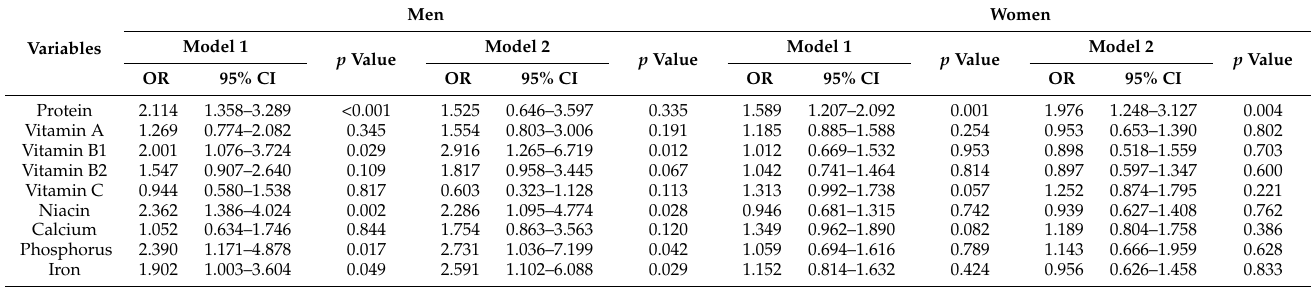
Table 3. Odds ratios for LGS according to inadequate nutrients intake.